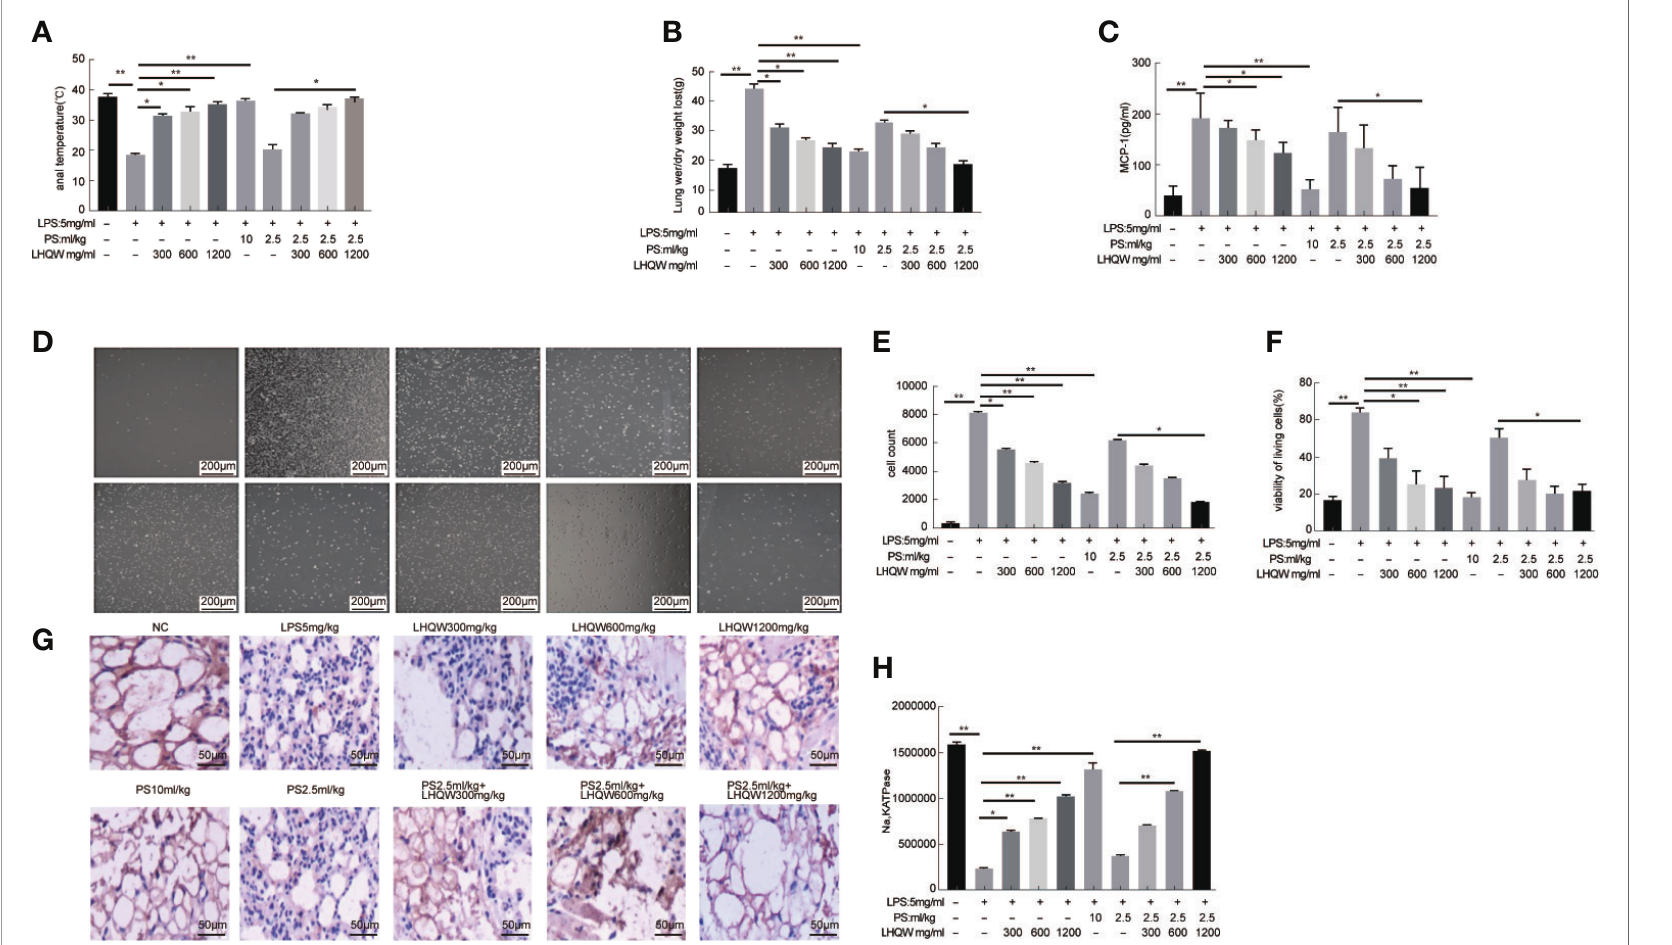
FIGURE 1 | Lian Hua Qing Wen capsule (LHQW) signi fi cantly protected lung tissue from in fl ammatory damage and functioned synergistically with antibiotics in an lipopolysaccharide (LPS)-induced Acute Lung Injury (ALI) model. At 24 h after the last drug treatment, all mice were anesthetized with 4% chloral hydrate (0.4 g.kg -1 ) and placed in the supine position on the surgical board. Control mice were instilled with saline, and others were treated with LPS (5 mg·kg-1). All of the above processes were performed on a ventilator. (A) Effects of LHQW on anal temperature. (B) Effects of LHQW on lung wet/dry ratio. (C) Effect of LHQW on MCP1 secretion. (D – F) Effects of LHQW on the measurement of in fi ltrated cells in BALF were measured with CCK-8 and microscope assays(40×). Lung tissue from ALI model mice were fi xed in 4% PFA, then